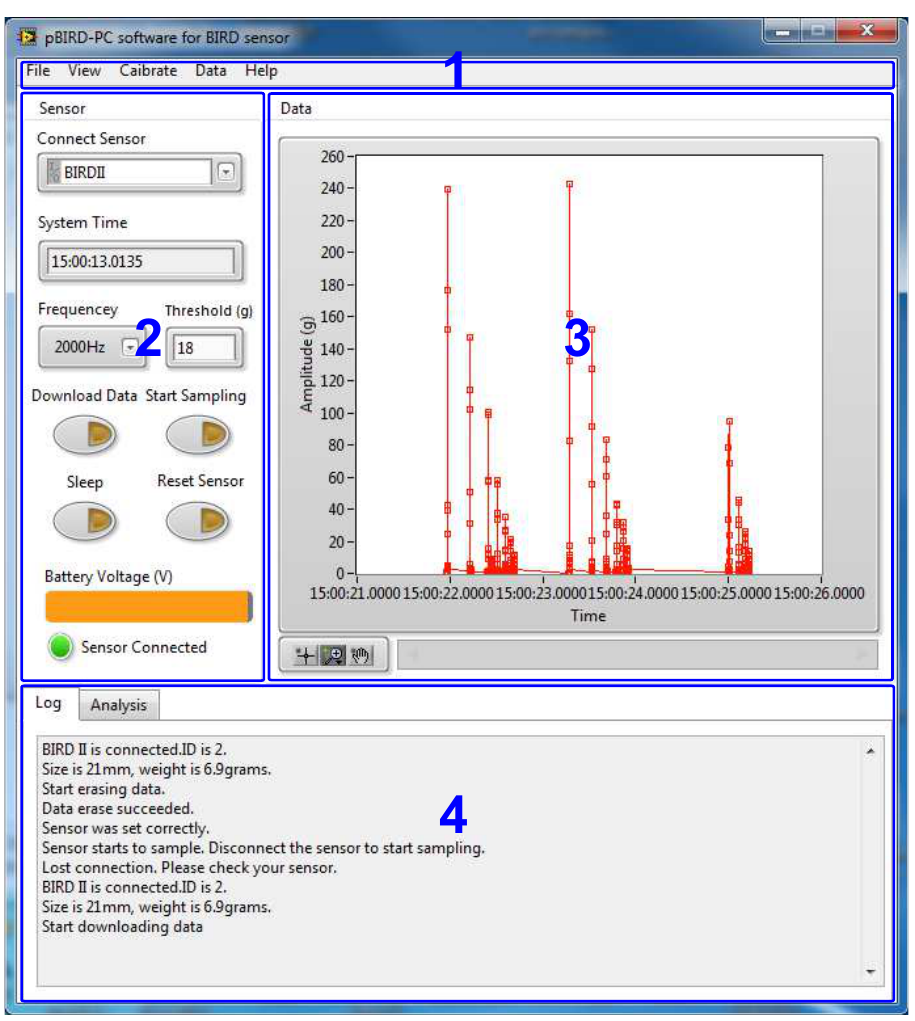
Figure 6. Front panel of the main PC program. 1 , Menu bar; 2 , sensor configuration; 3 , data visualization; 4 , operation